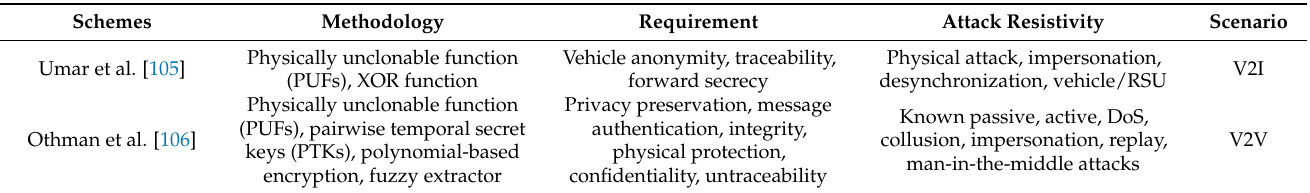
Table 11. Classification of hardware-physical-unclonable-function-based authentication schemes.